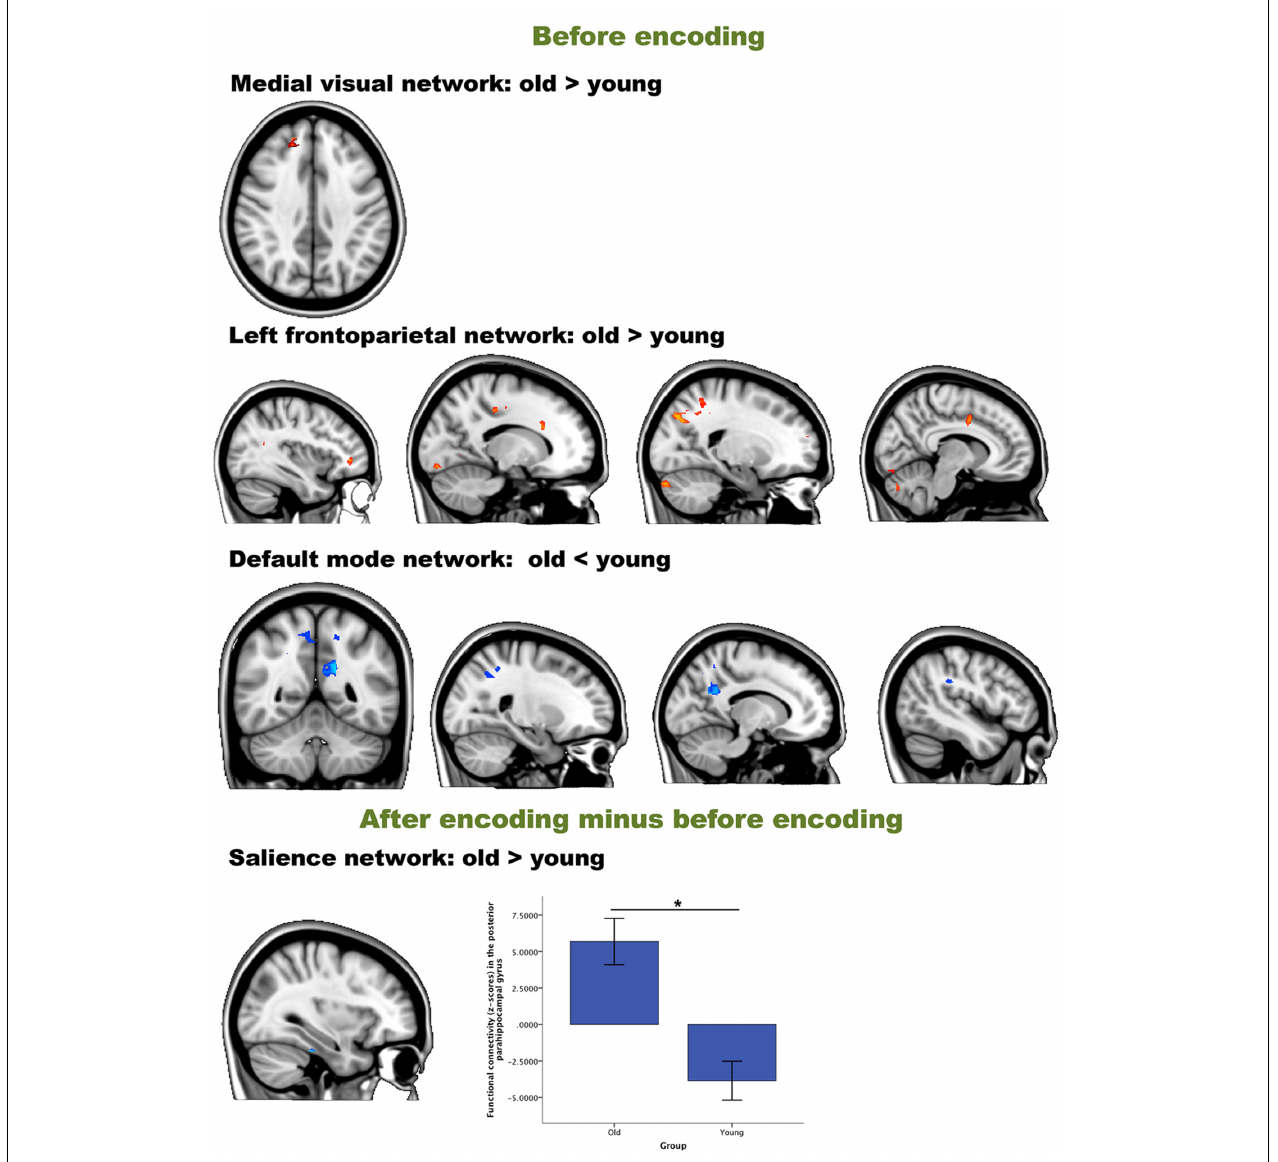
FIGURE 4 | Resting-state differences between older and young participants for the whole brain. Whole-brain group differences were found for the contrasts “before encoding” and “after encoding minus before encoding.” Blue clusters show decreased connectivity in older